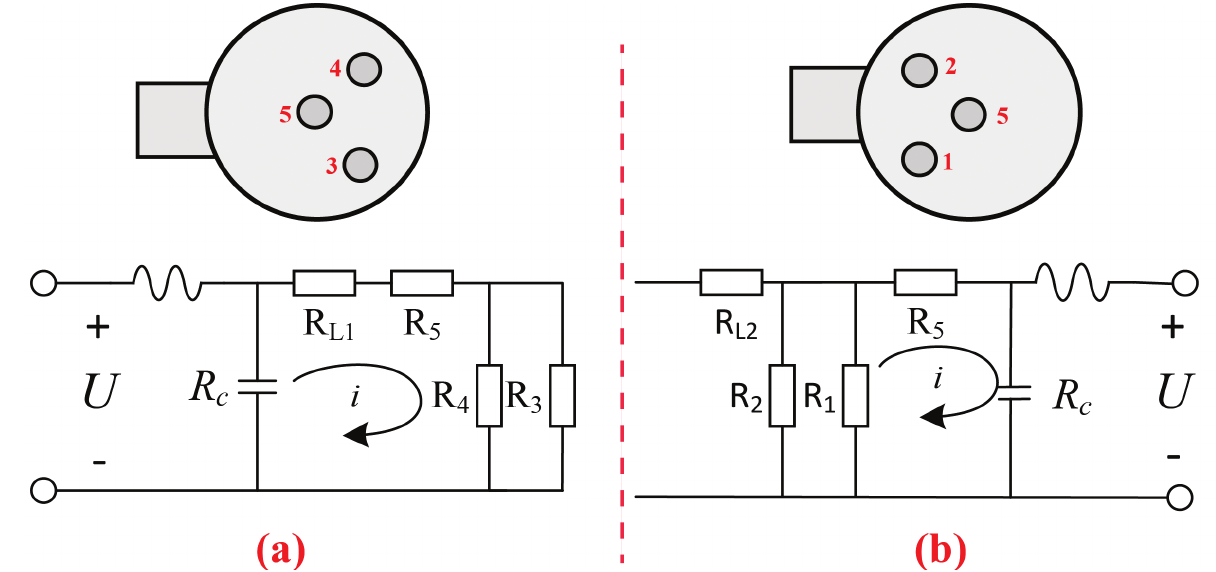
Figure 10: Schematic diagram of equivalent impedance